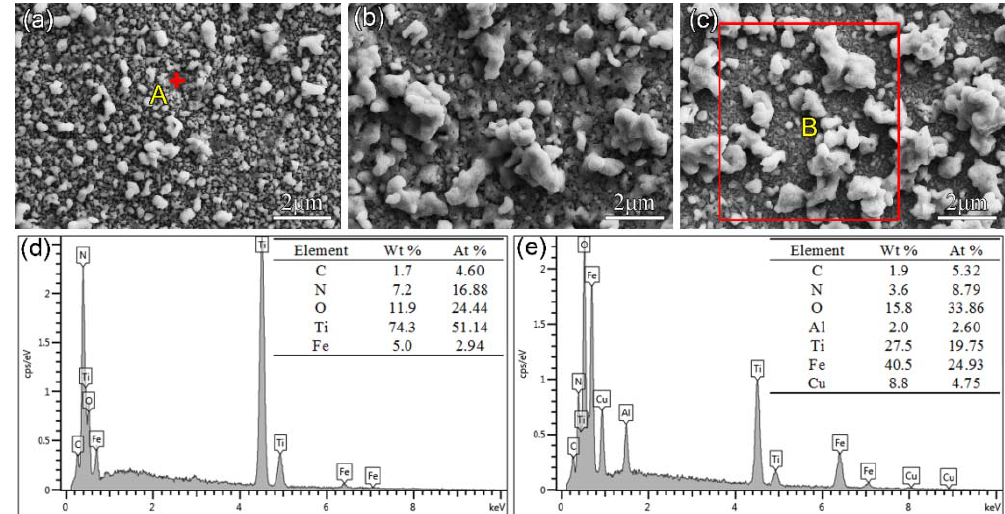
Figure 3. Surface morphology and the EDS results for the Cu-Ti film on C61900 Cu alloy after plasma nitriding at 650 °C for 4 h: ( a ) F1, ( b ) F2, ( c ) F3, ( d ) EDS result for point A in ( a ), ( e ) EDS result for region B in ( c ).